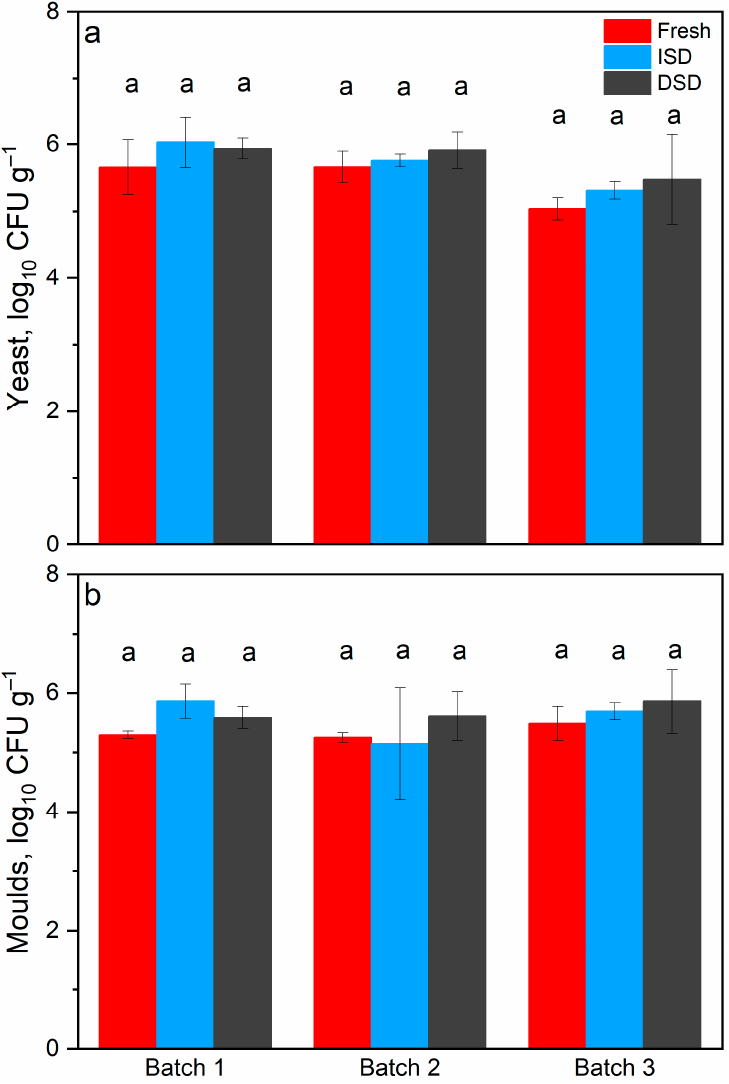
Figure 4. Colony counts per g dry matter for yeast ( a ) and moulds ( b ) in maize before drying (fresh) dried in the inflatable solar dryer (ISD) and dried under direct sun (DSD); three batches (Treatments with same letters are not significantly different, p ≤ 0.05).